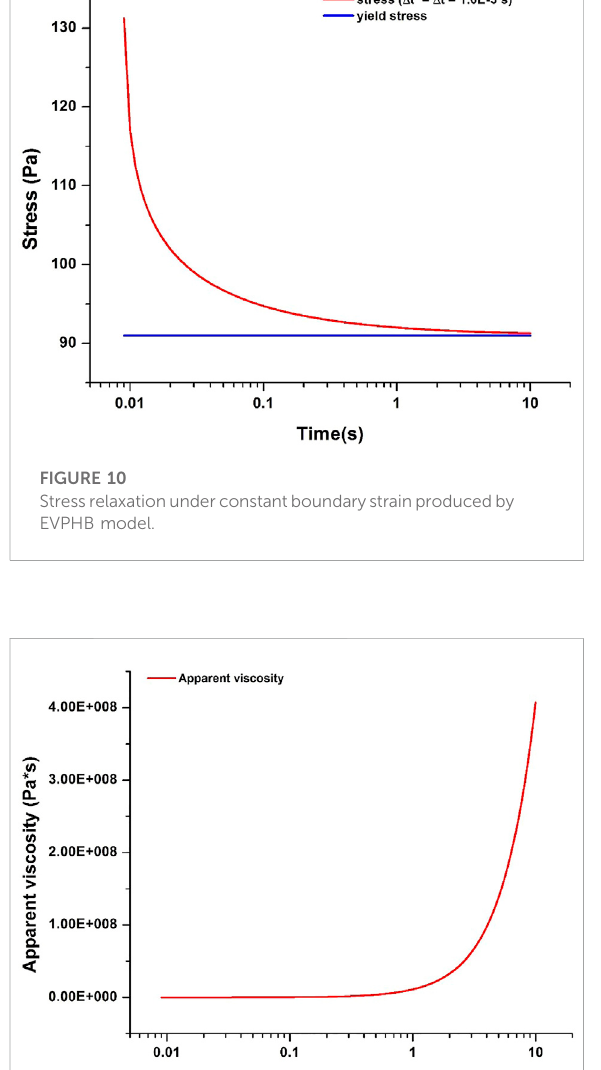
FIGURE 11 Apparent viscosity variation produced by EVPHB